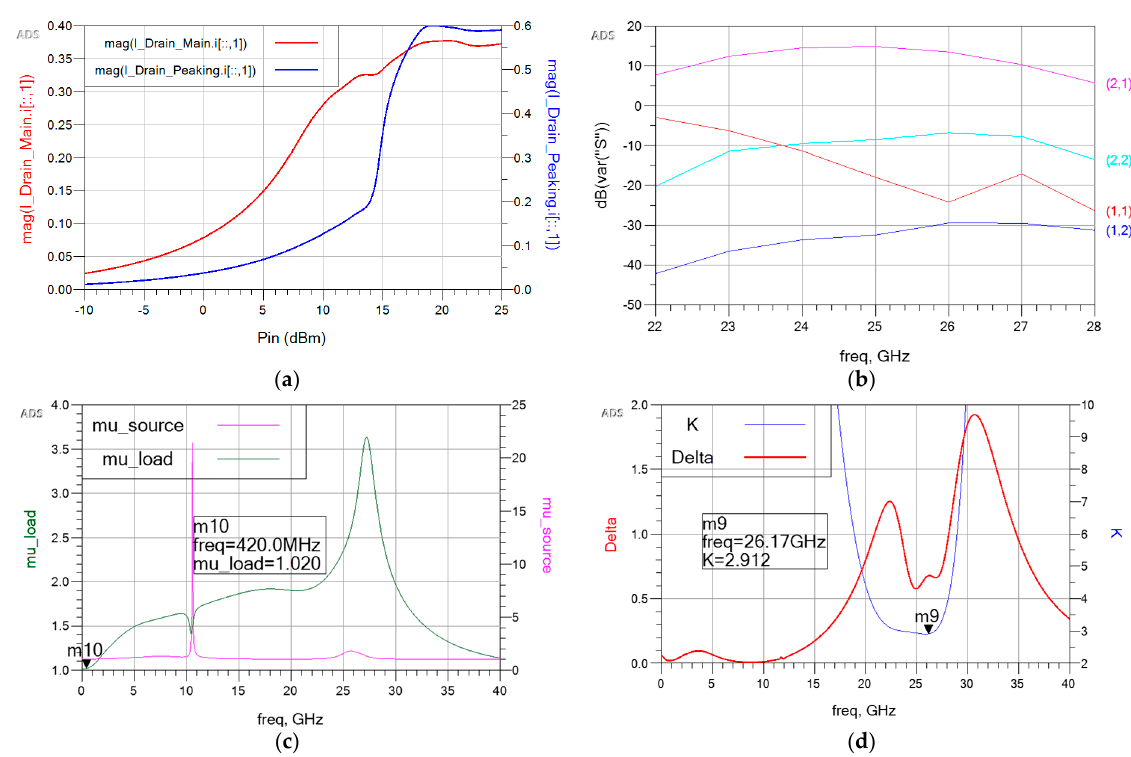
Figure 9. ( a ) Simulated PAE and drain efficiency magnitudes, along with the output power (dBm) vs. frequency, ( b ) the power gain of the main PA, and the transducer power gain of the DPA in terms of frequency.